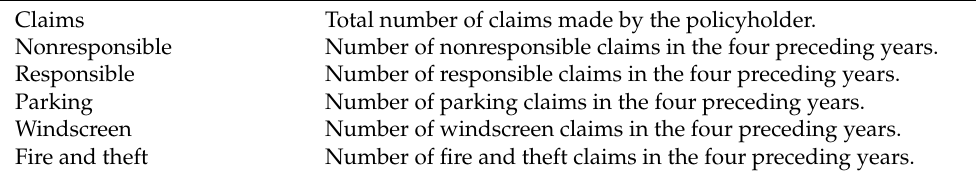
Table 1. Description of the response variables considered.